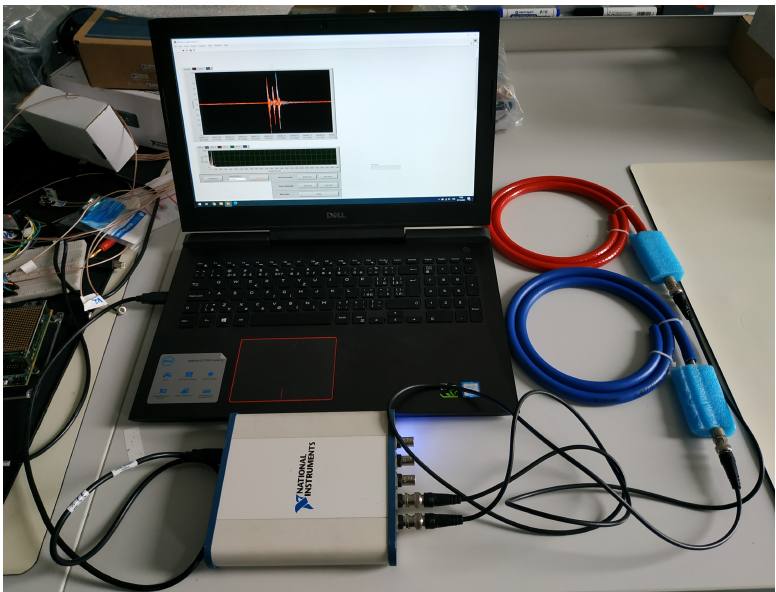
Figure 5. Example of connection of the pneumatic